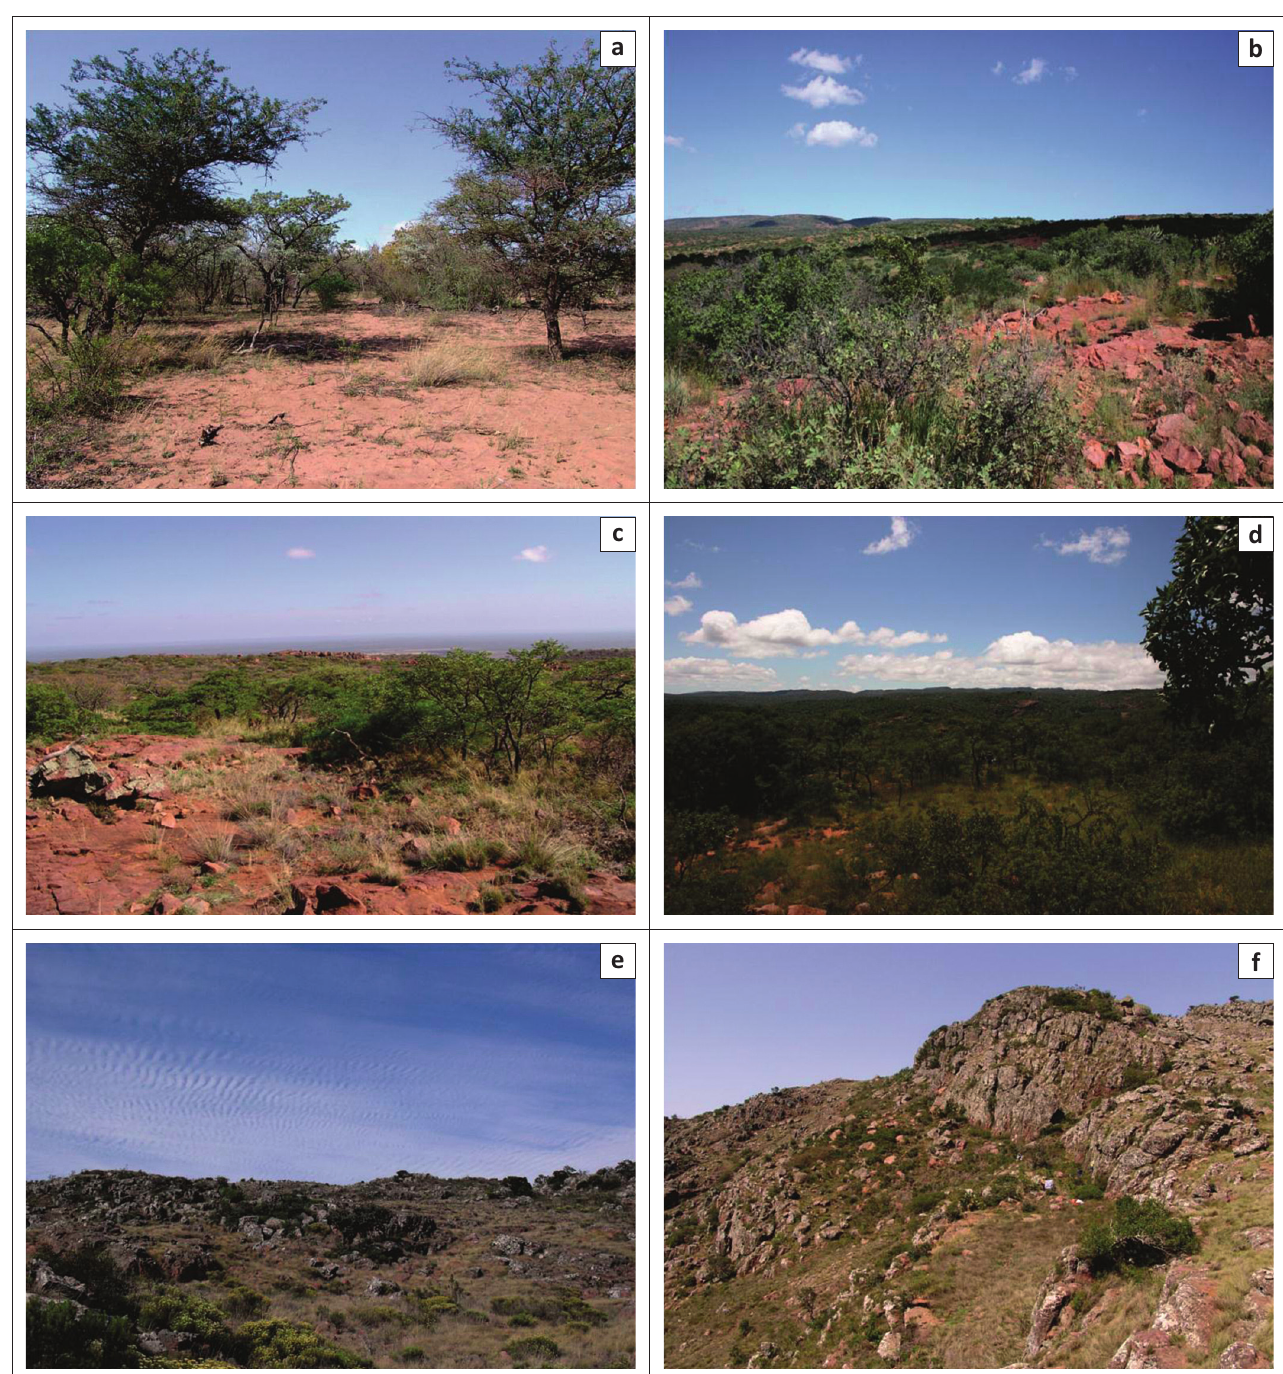
FIGURE 2: (a) 08N and (b) 12N deep sandy soils characterised by trees such as Adansonia digitata, Acacia nigrescens and Terminalia sericea . (c) 10N and (d) 14N are on shallow quartzitic soils and include Burkea africana, Ochna pulchra, Diospyros dichrophylla, Rhus magalismontanum, Boscia albitrunca and Terminalia sericea . Higher elevation sites (e) 17N and (f) 16S low shrubland patches with shallow rocky soils on quartzite, dominated by Coleochloa